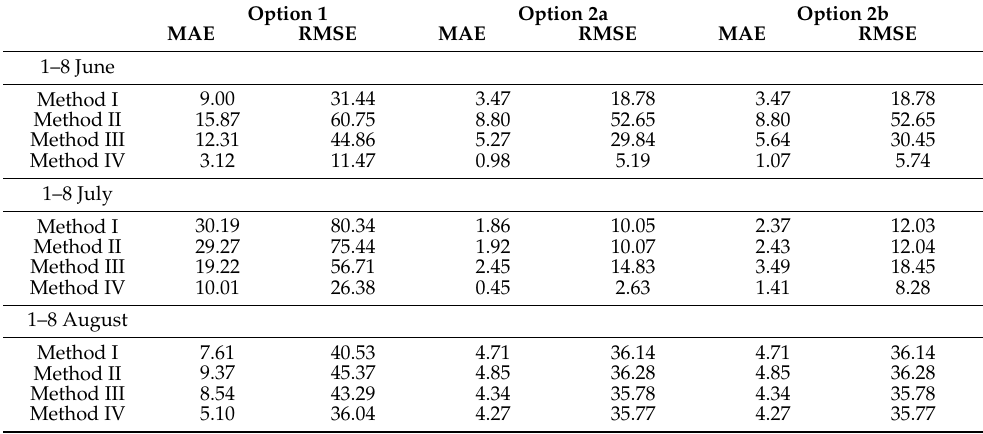
Table 3. Error metric for baselines in the first weeks of June, July and August, 2019. Units in